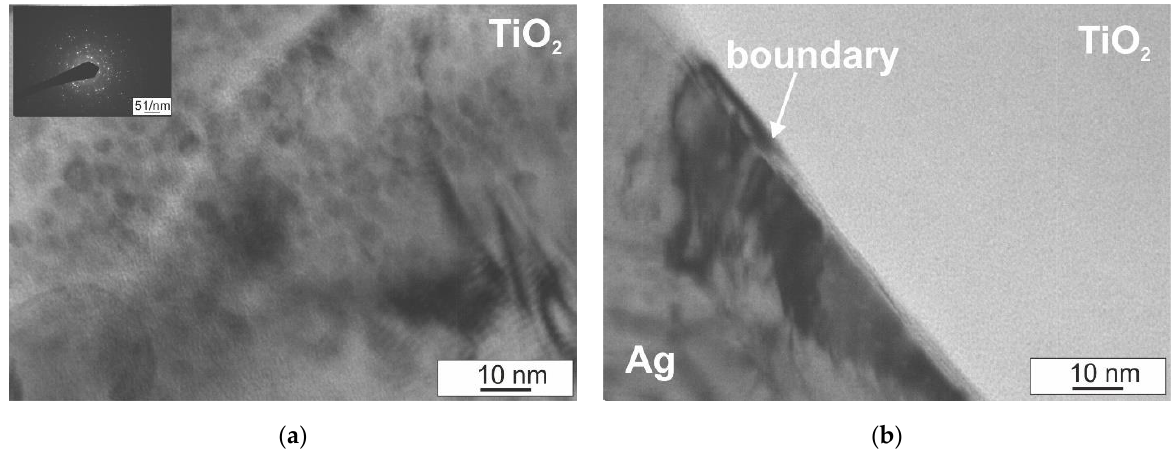
Figure 9. Microstructure of as-sintered Ag–TiO 2 composite, p = 500 MPa; ( a ) TiO 2 ; ( b ) boundary between silver matrix and